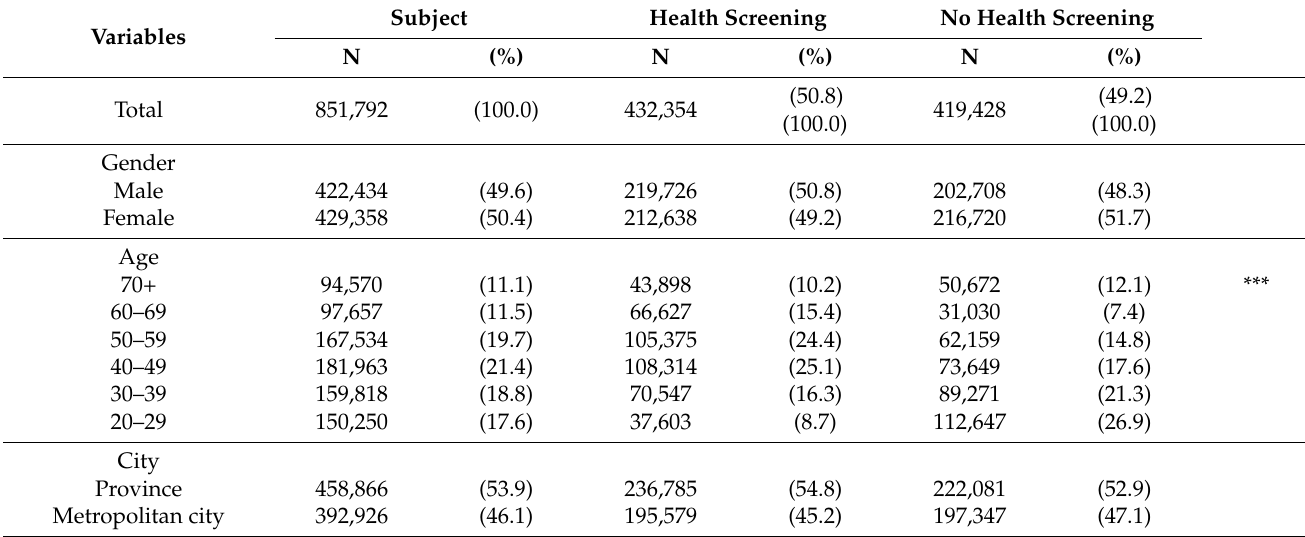
Table 1. The distribution of study sample between 2014 and 2015 in the National Health Insurance Sharing Service (NHISS).